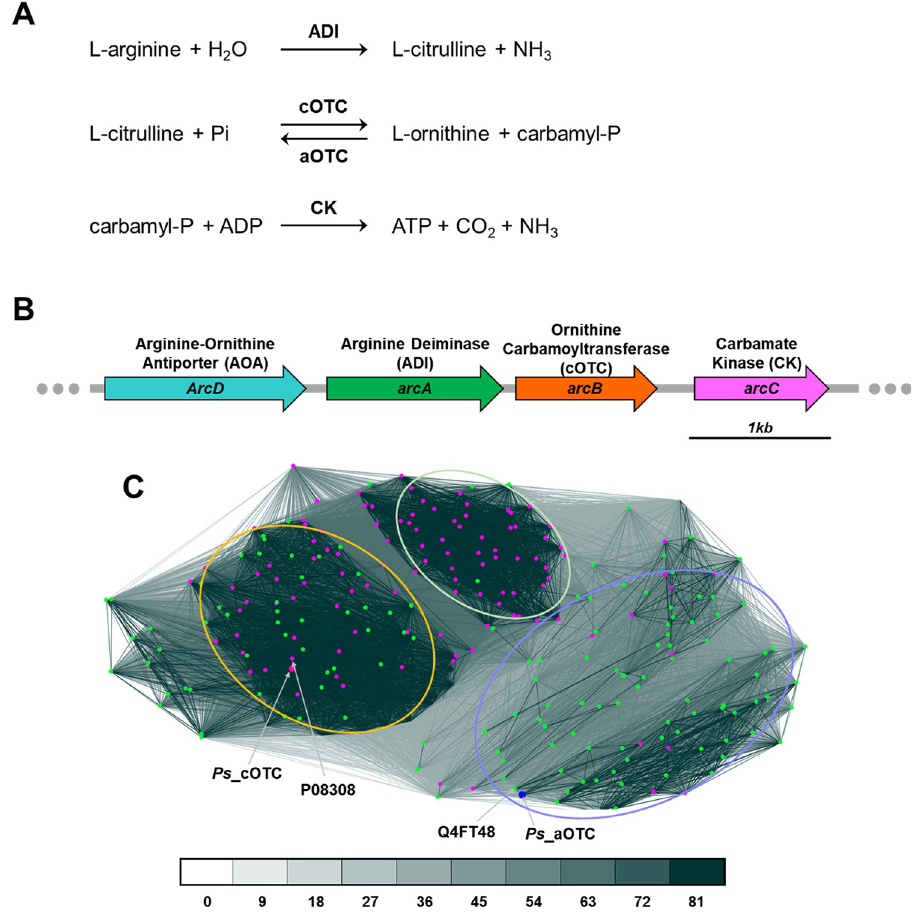
organization within the ADI system of the PAMC 21119 strain. (C) Clustering analysis of OTCs searched using ProtBLAST/PSI-BLAST from the PBD and Uniprot_sport databases. The three clusters are indicated with light green, purple-blue, and orange circles. The genes annotated with arcB or argF are indicated with green and purple dots. Ps _cOTC and Ps _aOTC are indicated with red and blue dots. Darker and shorter connecting lines indicate higher sequence similarity. Connections with P-values higher than 1e-x are drawn in the corresponding color (x = number